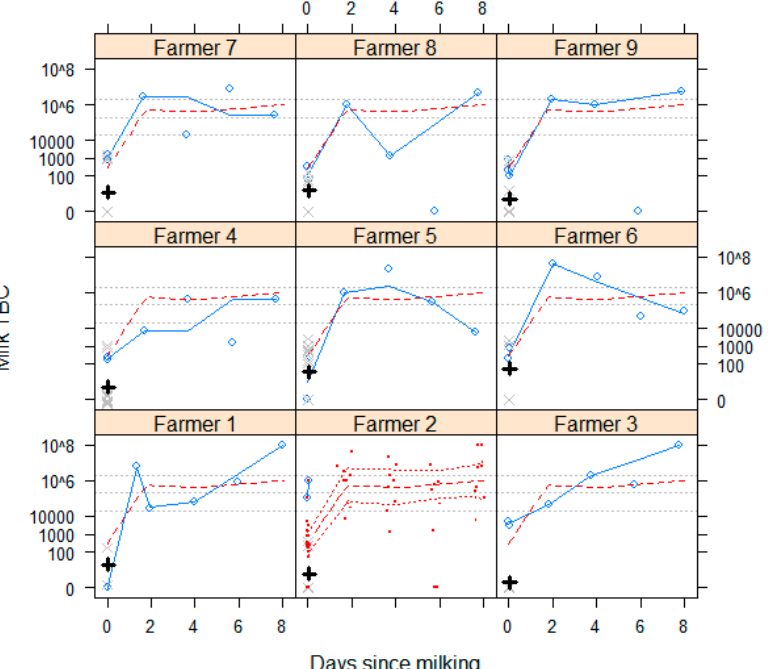
Figure 4. Blue circles show total bacterial counts (TBC) for pooled milk samples from each farm, taken on-farm immediately after milking and on arrival at the dairy cooperative (both days since milking = 0), followed by samples of refrigerated milk taken for up to eight days after milking. These points are joined by a blue Lowess smoothed line. Individual cow samples at milking (day 0) are shown using grey crosses with their geometric mean in black. Serial samples were not collected after arrival at the cooperative for farmer 2. A Lowess smoothed average TBC for all pooled samples from all farms is shown on all panels as a red dashed line, with upper and lower 95% confidence intervals for this Lowess all-farms’ average TBC shown on the panel for farmer 2, all TBCs for all farmers are also shown on this panel as red dots. TBC thresholds indicated by grey dotted lines show 20,000 cells/mL = EU legal limit for raw milk sold for consumption; 200,000 cells/mL = Zambia grade B upper limit and COMESA grade A upper limit; and 2,000,000 cells/mL = upper COMESA limit for milk to be processed. COMESA = Common Market for Eastern and Southern Africa.